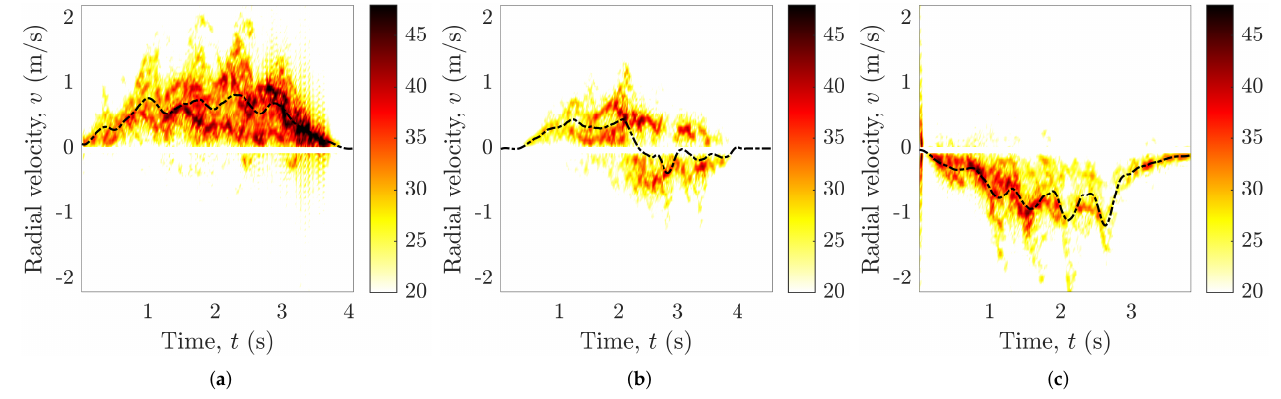
Figure 3. For a SISO radar system, the measured radial velocity distribution p 11 ( v , t ) and mean radial velocity ¯ v 11 ( t ) of a human walking activity for ( a ) Scenario 1, ( b ) Scenario 2, and ( c ) Scenario